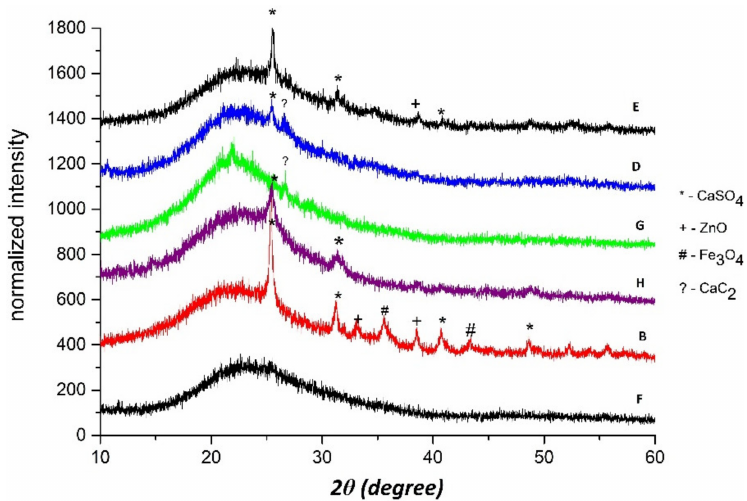
Figure 8. XRD analysis of piston deposits from engines located in landfills B,